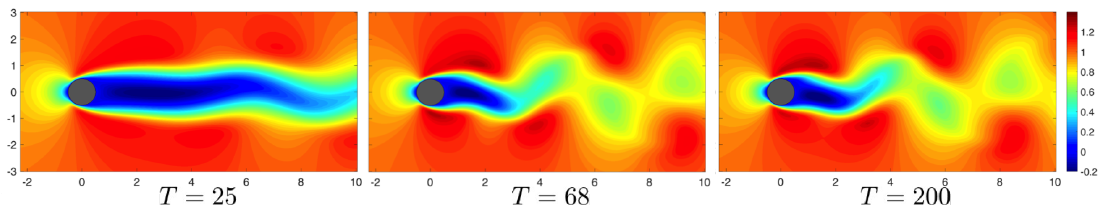
Figure 4. Isocontour plots of the stream-wise velocity component for the cylinder flow at Re = 100 at T = 25,68, 200 show evolution of the flow field. Here, T represents the time non-dimensionalized by the advection time-scale.